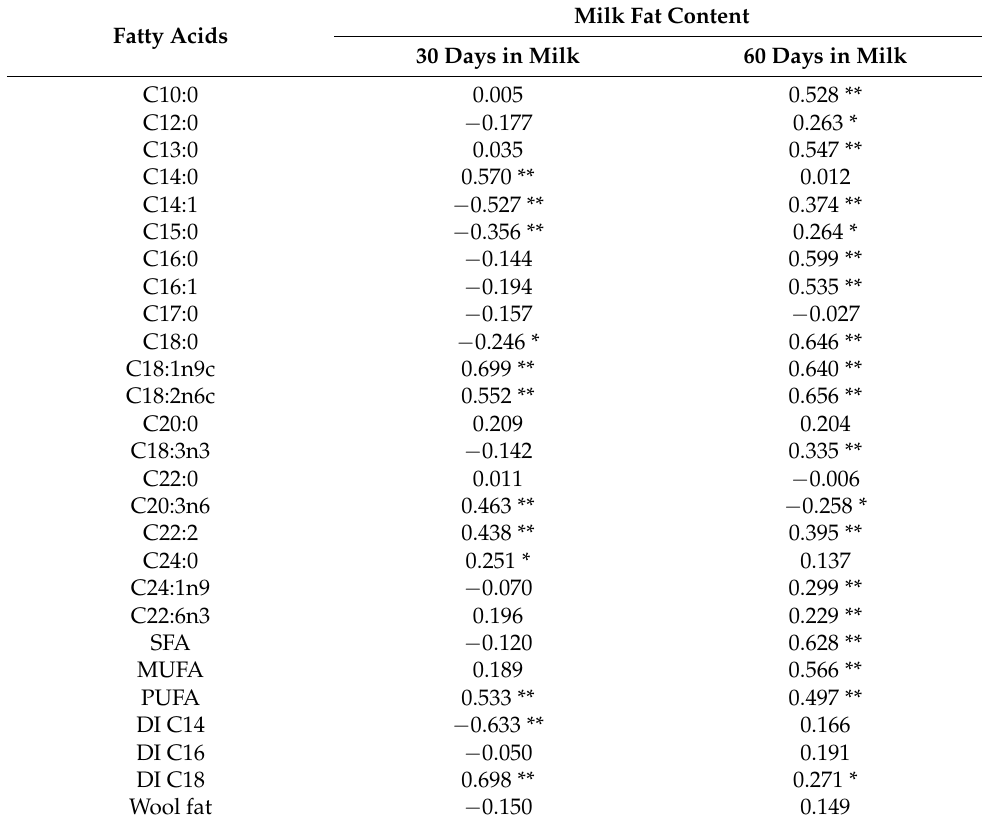
(Table 3). For each classification, C18:1n9c, C18:2n6c, and C22:2 were the only FAs that demonstrated a positive correlation between each classification period (30 and 60 days) and milk fat content. Furthermore, in the first period of 30 days in milk, positive correlations were determined in SFAs (C14:0 and C24:0) and PUFA (C20:3n6). For the FA proportions and DI, only the PUFA content and DI C18 exhibited a positive correlation with milk fat content. Moreover, negative correlations were determined for SFA (C15:0 and C18:0), MUFA (C14:1), and DI C14 with milk fat content. In the second period of 60 days, the SFAs (C10:0, C12:0, C13:0, C15:0, and C16:0), MUFAs (C14:1, C16:1, and C24:1n9), and PUFAs (C18:3n3 and C22:6n3) were positively correlated with milk fat content. Moreover, the proportions of all FAs, i.e., SFA, MUFA, and PUFA, and DI C18 were shown to have a positive correlation with milk fat content in this period, with the exception of the FA C20:3n6, which exhibited a negative correlation. Table 3. Pearson’s correlation coefficients among wool fatty acid content and milk fat content. Milk Fat Content Fatty Acids 30 Days in Milk 60 Days in Milk C10:0